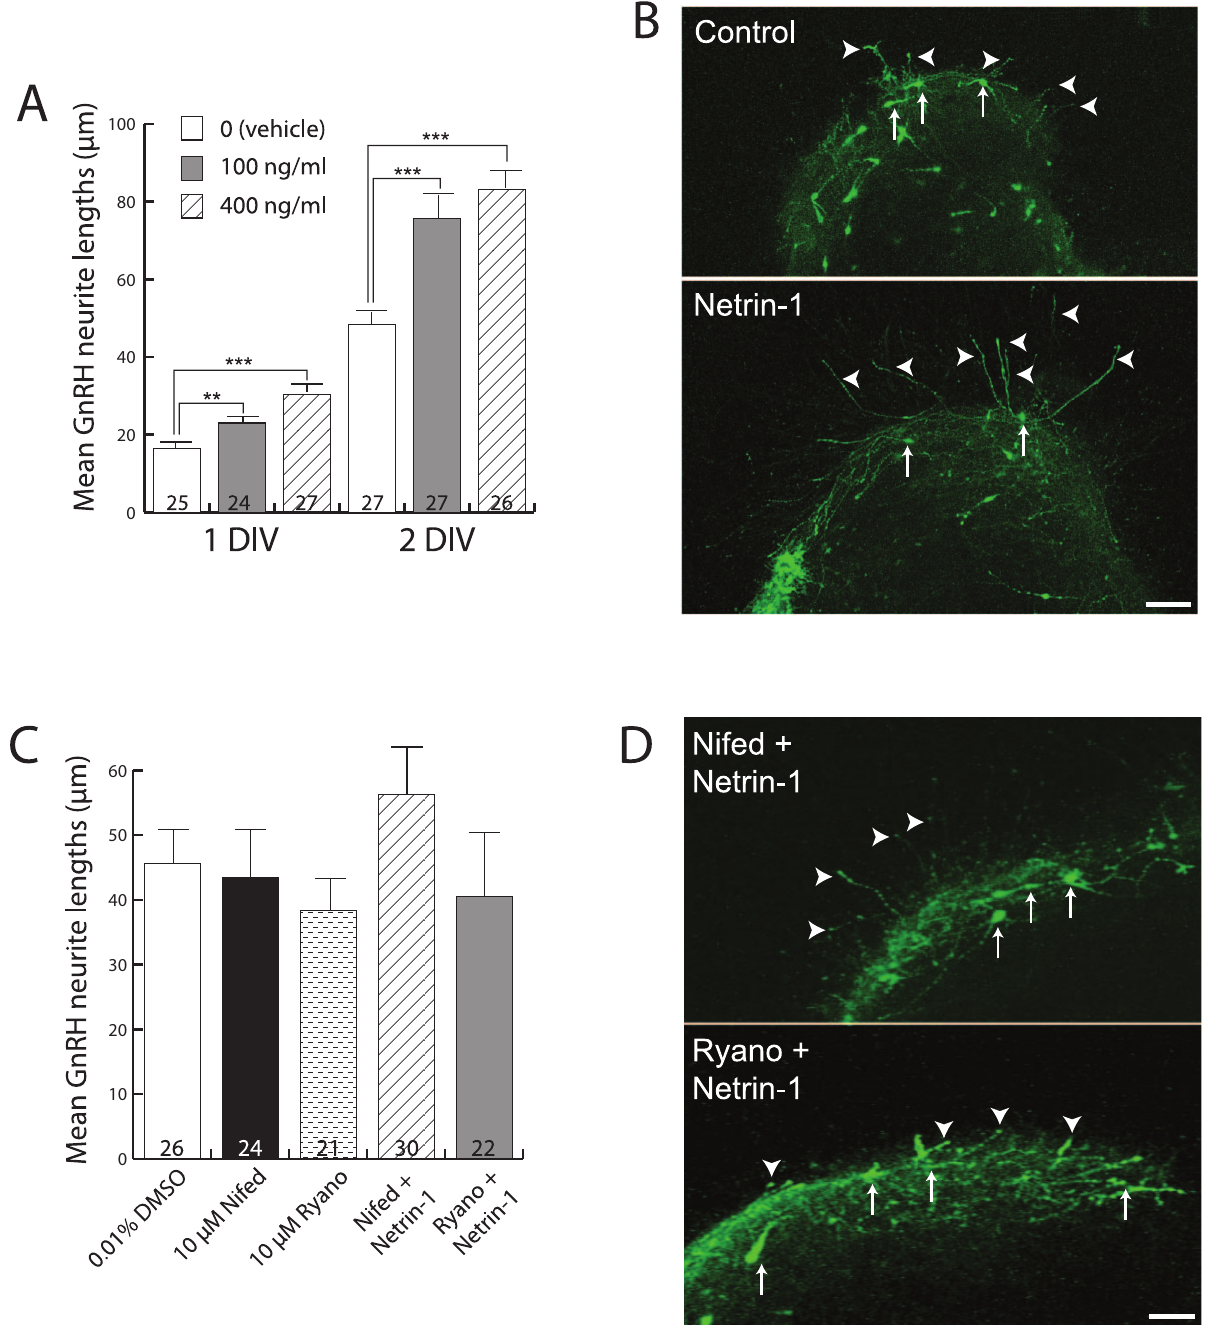
Figure 2. Netrin-1 stimulates the growth of GnRH neurites in a calcium-dependent manner. (A) Bar graph showing mean GnRH neurite lengths at 1 and 2 DIV across the three different treatments (indicated in inset legend). Numbers at the base of each bar indicate the number of explants used, and are from fetal brains derived from 5 independent pregnancies (average of 8 fetuses/pregnancy). Error bars indicate SEM. **, P , 0.01 and ***, P , 0.001 with one-way ANOVA and Student-Newman-Keuls multiple comparison post-hoc test. (B) Immunofluorescence images for detection of GFP peptide as a surrogate marker for GnRH neurons (arrows) of explants grown for 2 DIV. Note the clear difference in the length of GnRH neurites (arrowheads) outside the explant borders in Netrin-1-treated (lower panel) by comparison with untreated (upper panel). Scale bar, 40 m m. (C) Bar graph showing mean GnRH neurite lengths (y-axis) at 2 DIV under the three treatment conditions indicated on the x-axis. Numbers at the base of each bar indicate the number of explants used, and are from fetal brains derived from 4 independent pregnancies. Abbreviations: Nifed=nifedipine, Ryano=ryanodine. Error bars indicate SEM. (D) Immunofluorescence images showing GFP-expressing GnRH neurons grown in explants in the presence of Netrin-1 plus either the L-type VGCC blocker Nifedipine (Nifed + Netrin-1, upper panel) or ryanodine (Ryano + Netrin-1, lower panel). Arrows indicate GnRH neuron cell bodies, and arrowheads indicate GnRH nerve fibers extending beyond the borders of the explants. Scale bar, 100 m